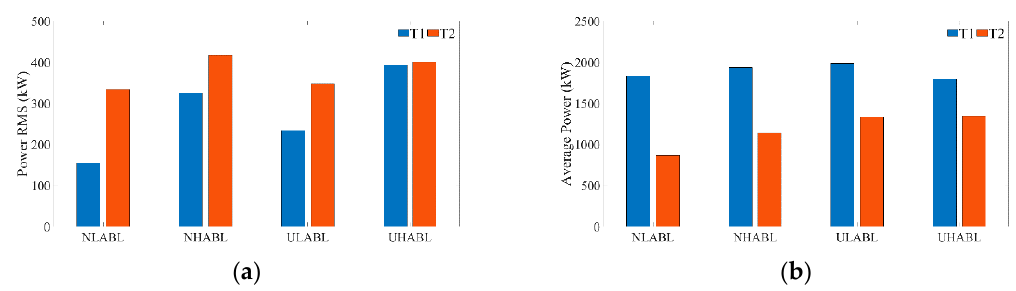
Figure 12. ( a ) Power root mean square (RMS) and ( b ) time-averaged power for NLABL, NHABL, ULABL, and UHABL. Refer to Table 1.